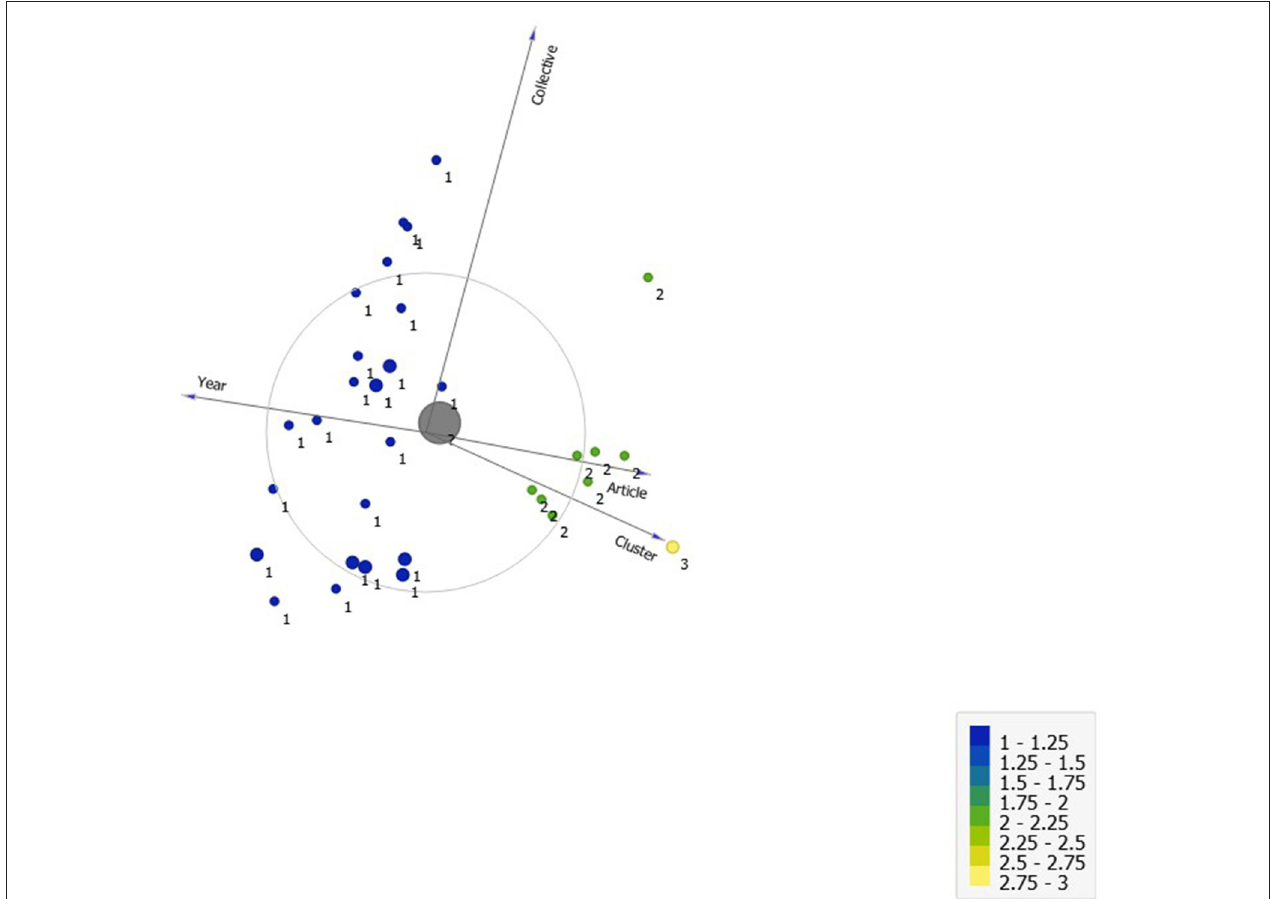
FIGURE 6 | Distribution of the groupings in the categories established in the articles in a principal components analysis.